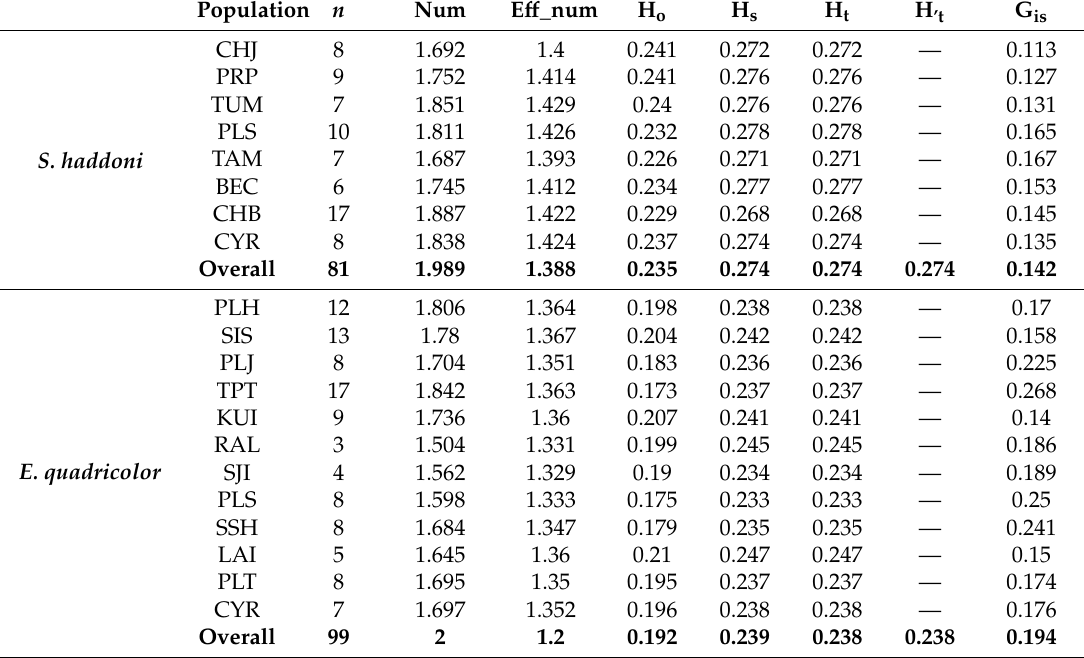
Table 2. Number of samples prepared for ddRADseq sequencing ( n ) per site and species and genetic diversity indices of Stichodactyla haddoni (sti_b1.10miss) and Entacmaea quadricolor (ane_b3.10miss), where Num = number of alleles observed, E ff _num = e ff ective number of alleles in a population weighted for their frequencies, H o = observed heterozygosity where 0 represents that all individuals are homozygous and 1 represents that all individuals are heterozygous, H S = expected heterozygosity, H t = total heterozygosity, H ’t = total heterozygosity corrected for bias from sampling limited populations, G is = inbreeding coe ffi cient; analogous to Wright’s inbreeding-coe ffi cient, F IS